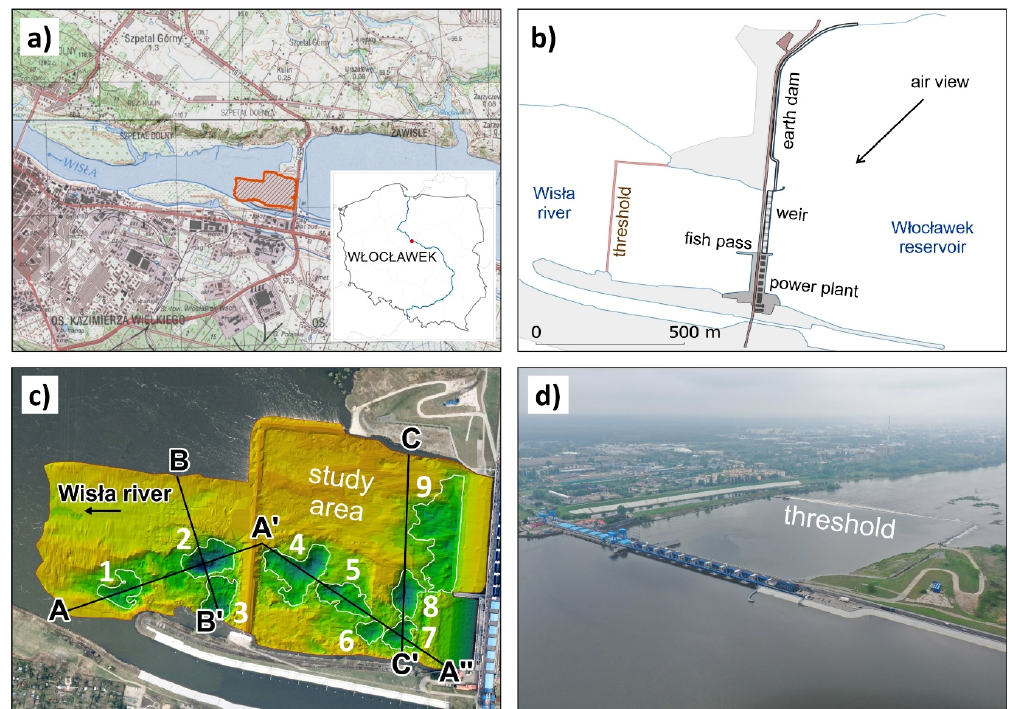
Figure 2. Study area: ( a ) location of power station Włocławek, ( b ) power station construction, ( c ) cross sections of the measured potholes, ( d ) photo ‐ documentation of the water power station.